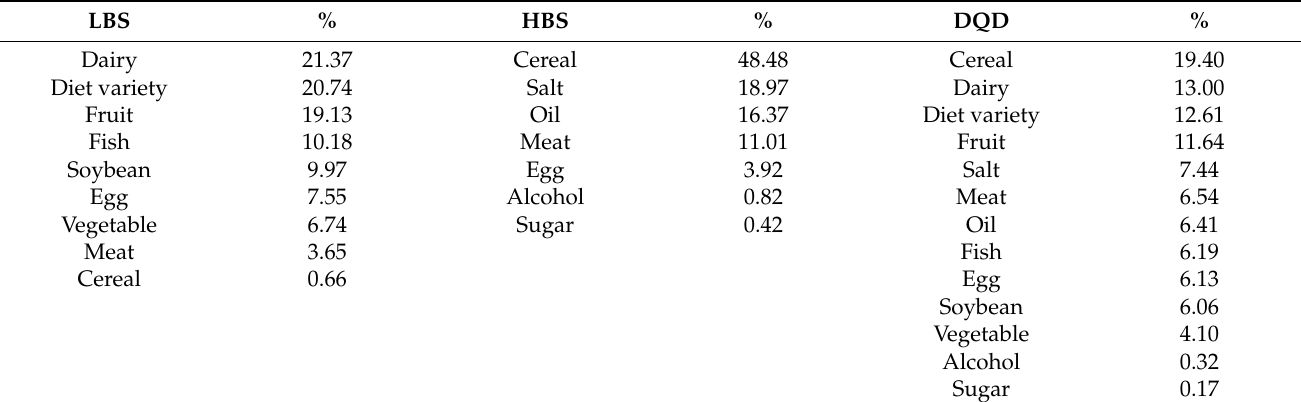
Table 1. Contribution rates of the DBI-16 sub-components on the LBS, HBS and DQD.